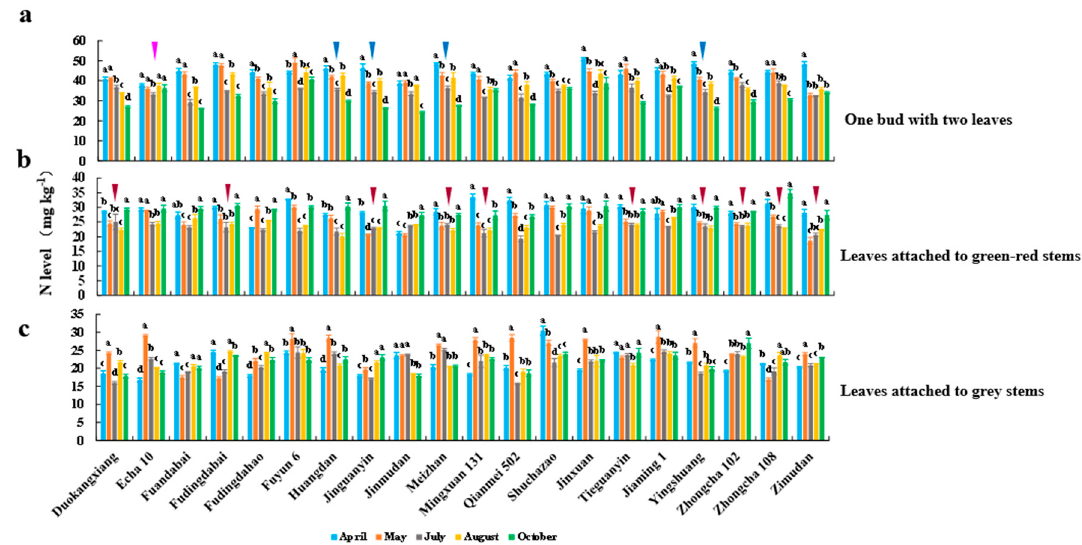
Figure A2. Dynamic changes of N level (g N kg − 1 DW) in the three categories of leaves, one bud with two leaves ( a ), leaves attached to green-red stems ( b ), and to grey stems ( c ) during the growing seasons. The blue triangles represent the four varieties showing the same pattern of dynamic change of N level of one bud with two leaves throughout the growing season, and the pink triangle shows a specific pattern in Echa 10. The red triangles indicate the ten varieties showing the same pattern of dynamic change of N level in the leaves attached to green-red stems throughout the growing season. Values are means ± standard (SD) ( n = 3). Error bars indicate SD. Significant differences are indicated by letters a, b, c, d, and e ( p = 0.05).